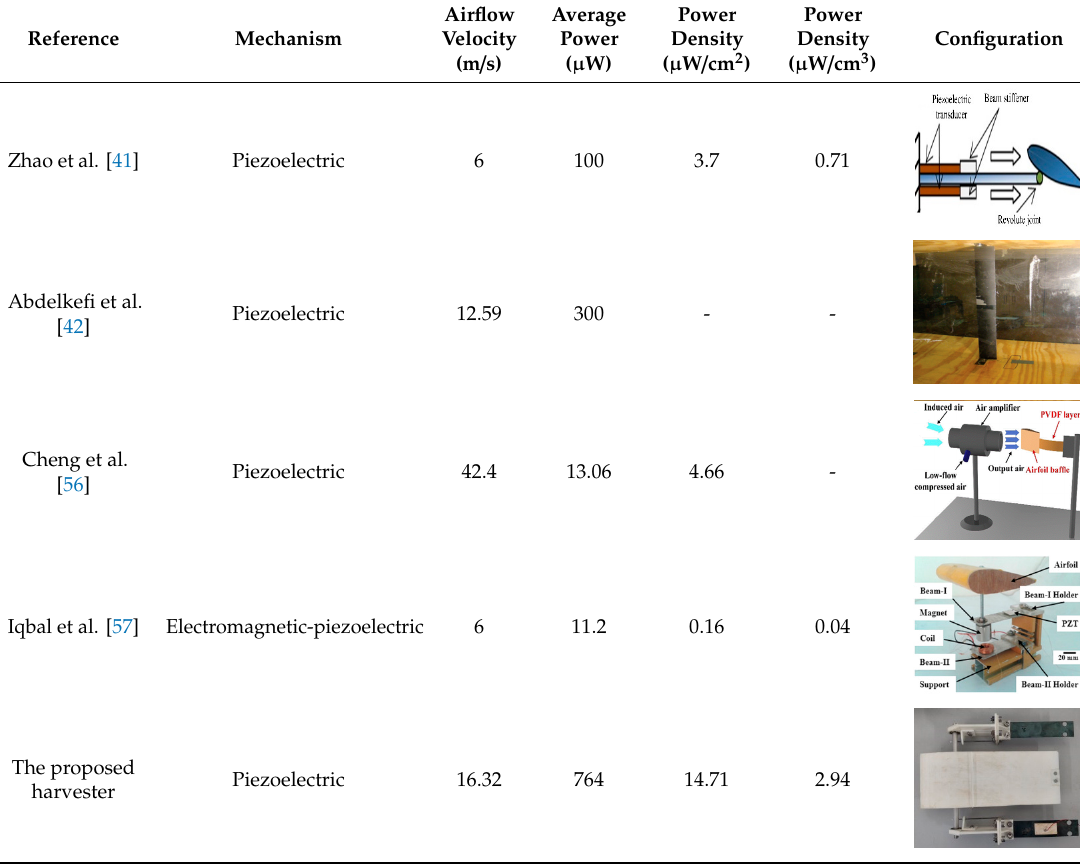
Table 2. Comparison of output performance between the previous and proposed harvesters.